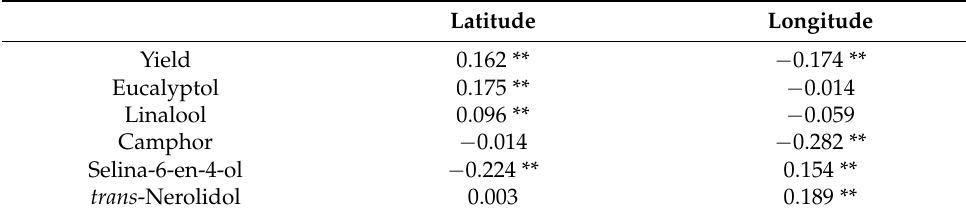
Table 2. Pearson correlation coefficients between essential oil and geographical position.